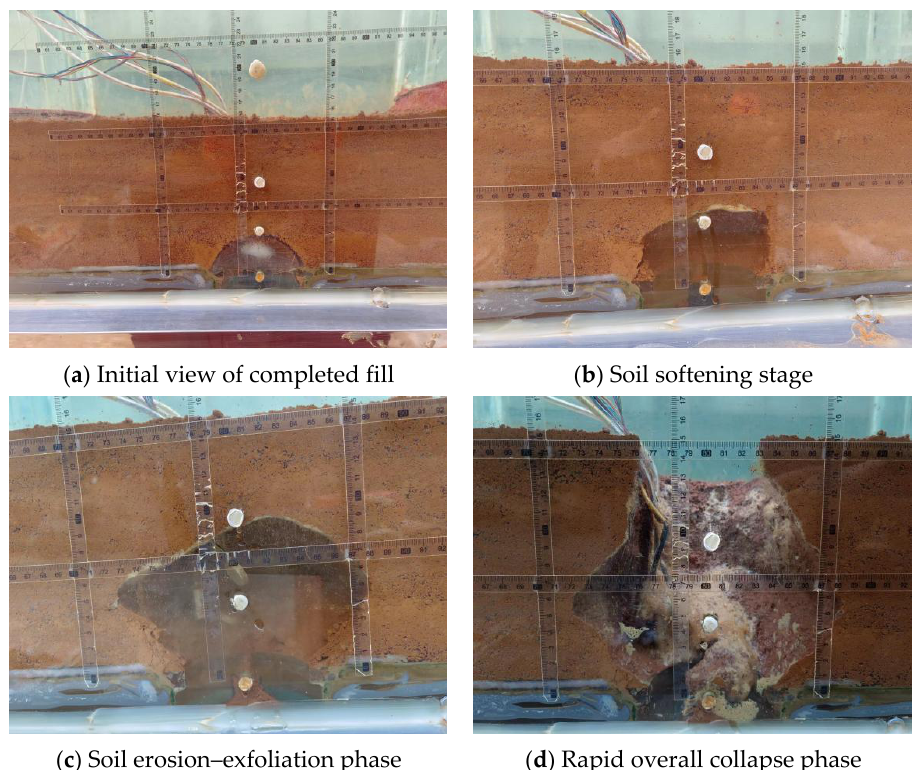
Figure 12. Schematic diagram of the development of the earth cave collapse.